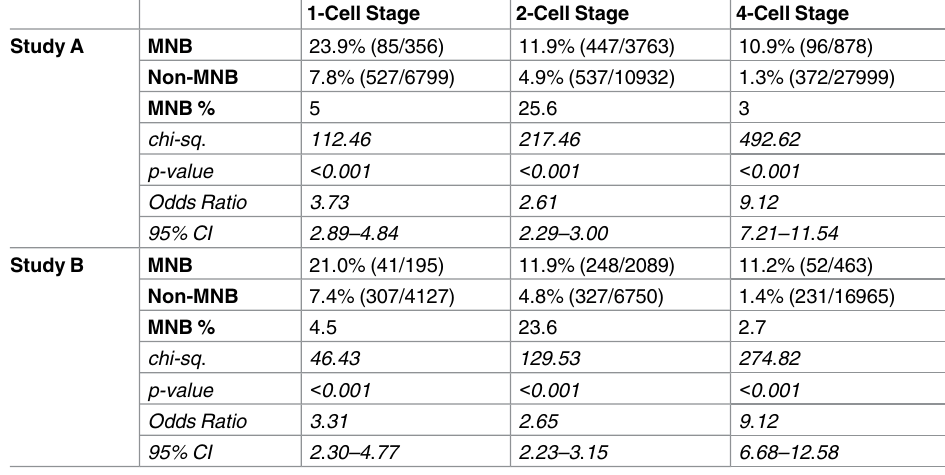
To further investigate the correlation of multinucleated blastomere and DUCs, 7155 embryos cultured only in 5% O were analyzed (Table 3 study A). Similarly, the chance of 2 DUCs were 2–9 folds higher in multinucleated blastomeres compared to mononucleated blas- tomeres even after the correction for the sperm source used (Table 3 study B). Table 3. Incidence of DUCs per blastomere and multinucleated blastomere